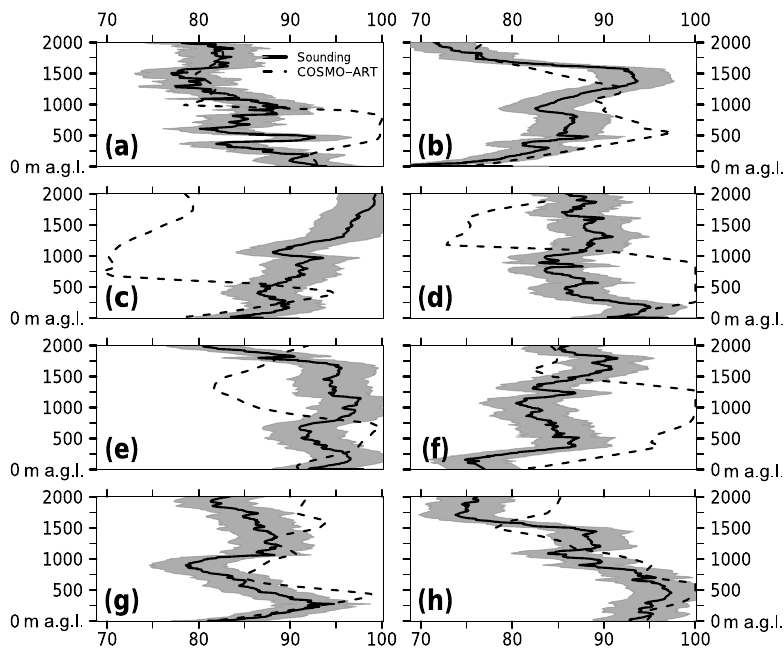
Figure B2. RH vertical profiles at Abidjan (Ivory Coast) with respect to radiosoundings (black solid) and COSMO-ART (black dashed) on (a) 2 July 04:00UTC, (b) 2 July 10:00UTC, (c) 2 July 16:00UTC, (d) 2 July 23:00UTC, (e) 3 July 04:00UTC, (f) 3 July 10:00UTC, (g) 3 July 16:00UTC and (h) 3 July 23:00UTC. For the Meteomodem radiosondes an uncertainty of ± 4% is assumed (gray